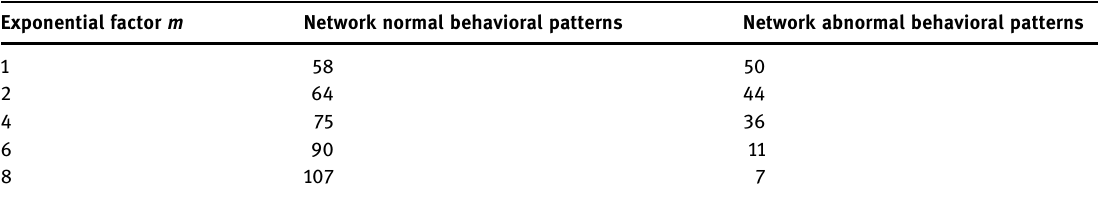
Table 7: Cluster analysis data Exponential factor